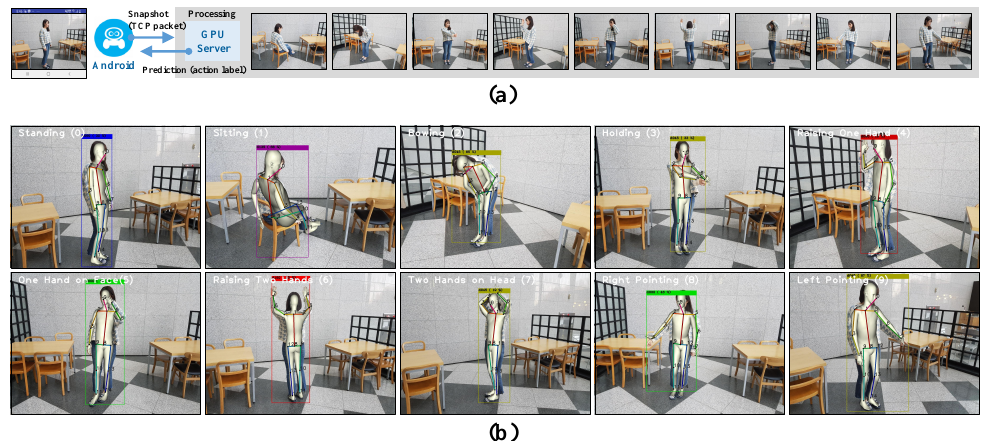
Figure 7. Application: ( a ) an example of inputs for mobile applications; and ( b ) our qualitative